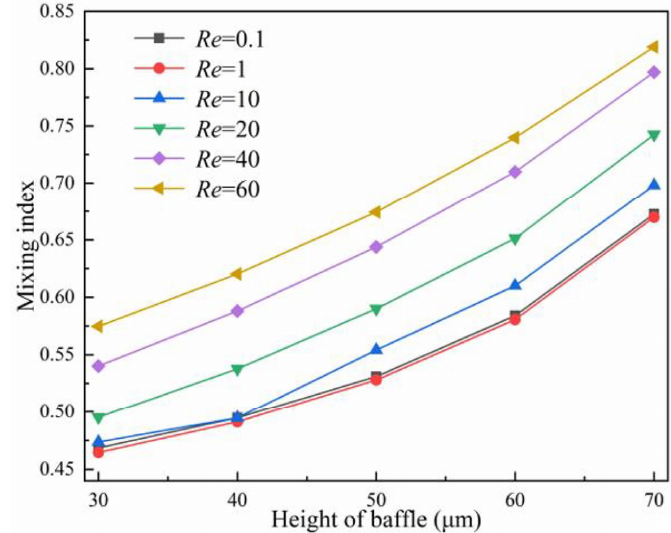
Figure 18. Effect of the height of baffle on mixing index.